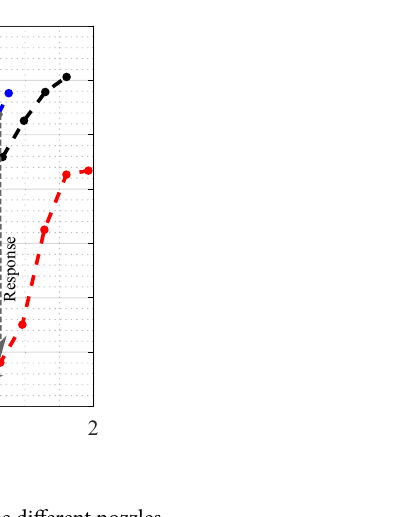
Figure 11. Comparison of rod 402 response with three different